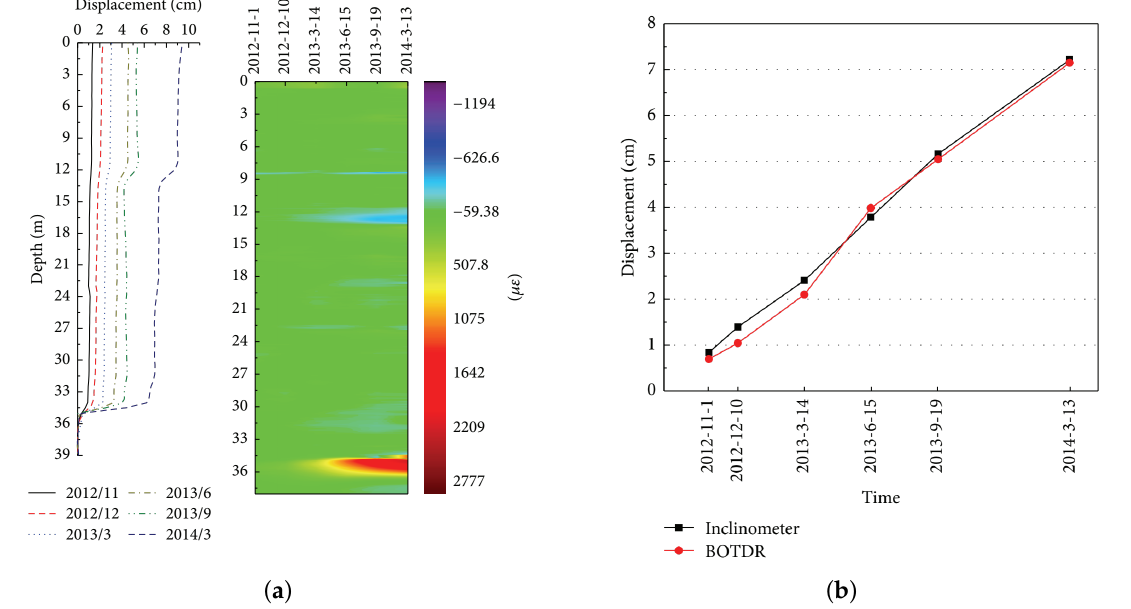
Figure 20. ( a ) Cumulative displacement curves measured by a BOTDR-based optical fibre inclinometer, and, on the right, the colour map of the strain field in time and space; ( b ) Displacement curves measured by the optical fibre inclinometer vs. a standard gauge. Reproduced with permission from